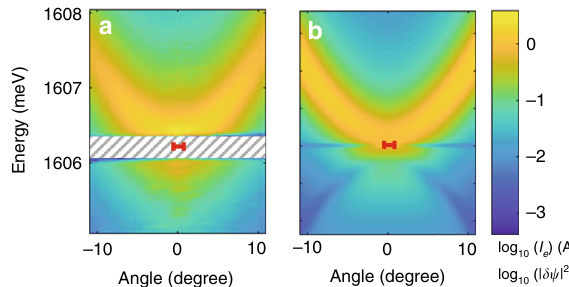
Fig. 4 Super fl uid excitations density analysis. a Measured cross-polarized EPL measurements in the upper branch of I 0 ð P Þ close to the switch-down point, with an enhanced signal-to-noise ratio of 300. b Calculated angle- and energy-resolved cross-polarized EPL from the full vectorial theory assuming a condensate fraction of ρ ¼ 50 % and experimental parameters from WPA. The intensity is color coded on a four decades logarithmic scale, and the laser energy and angular spread is shown as a red segment. The hatched rectangle shows the spectral range rejected by the notch fi